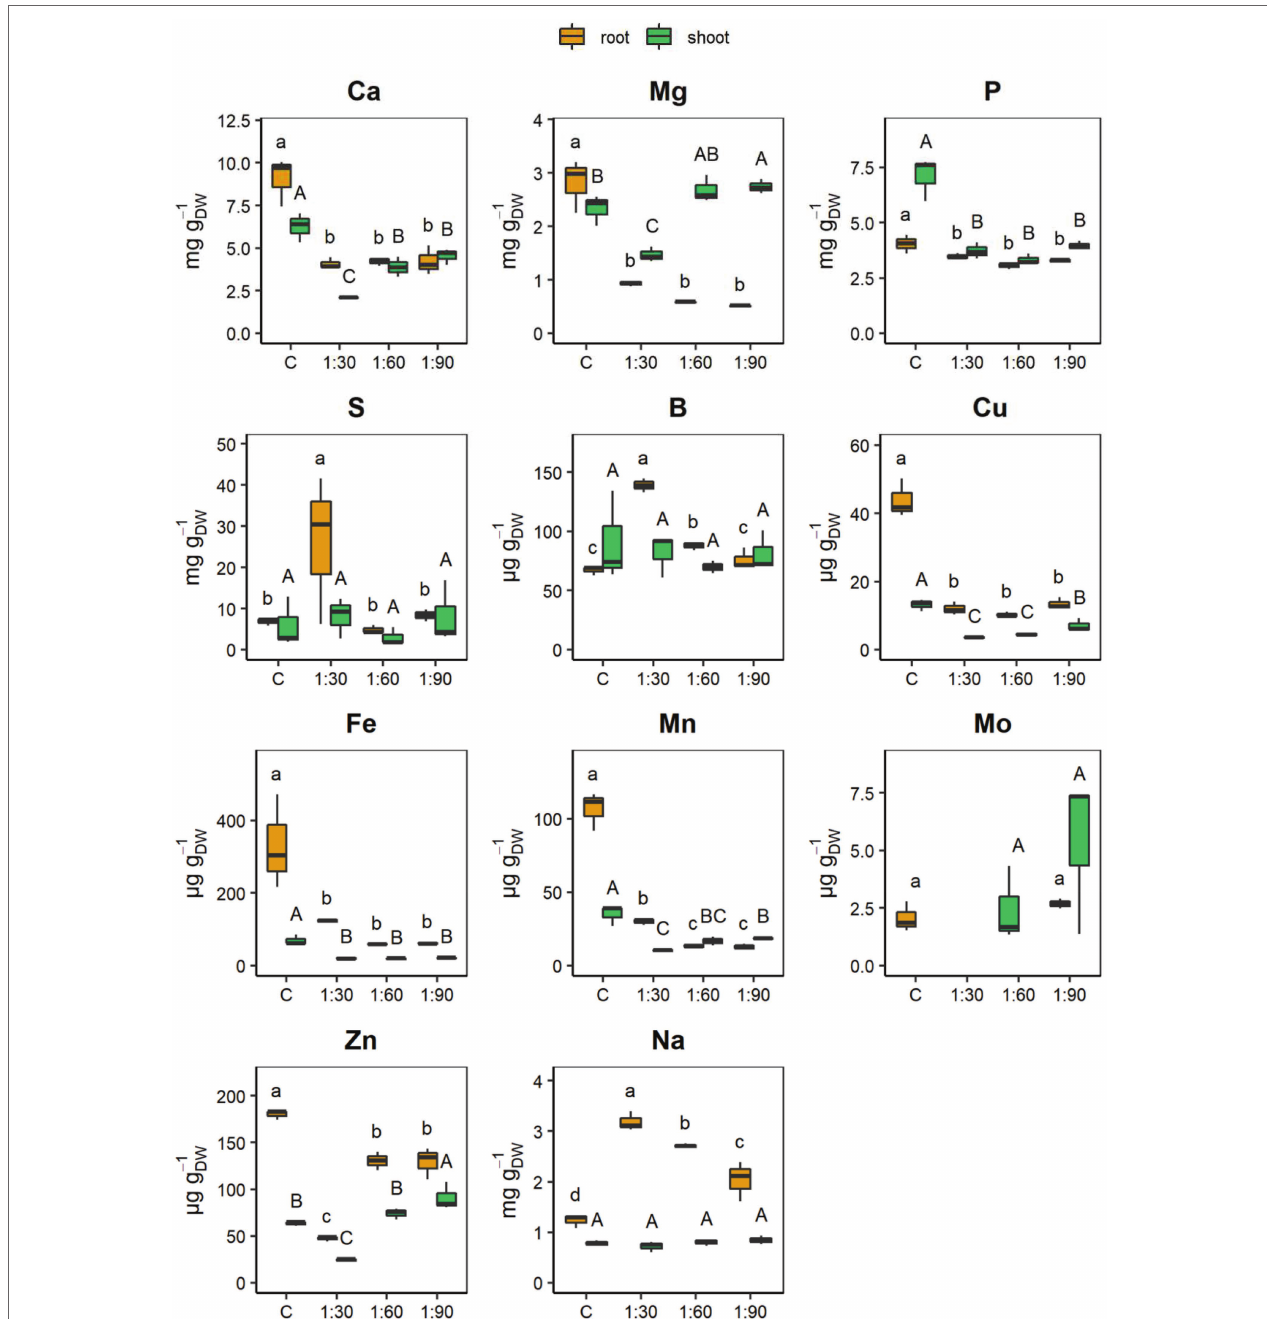
FIGURE 5 | Concentrations of main macro- [calcium (Ca), magnesium (Mg), phosphorus (P), and sulfur (S)] and micronutrients [boron (B), copper (Cu), iron (Fe), manganese (Mn), molybdenum (Mo), and zinc (Zn)], and sodium (Na) in roots and shoots of 15-day-old maize seedlings grown with the full-strength nutrient solution (C, control) and with the AHL diluted with distilled water in a ratio of 1:30, 1:60, and 1:90 (v/v). Boxplots were omitted when the concentration values are below the limit of detection (LOD). The LOD of Mo was 10.107 μ g L − 1 . Data are presented as means ± SE ( n = 12). Statistical significance was tested by one-way ANOVA analysis with LSD post-test ( p < 0.05). Statistically significant differences among the four different growth conditions are indicated by different letters: different lower case letters indicate significant differences among the growth conditions in roots; different upper case letters indicate significant differences among the growth conditions in